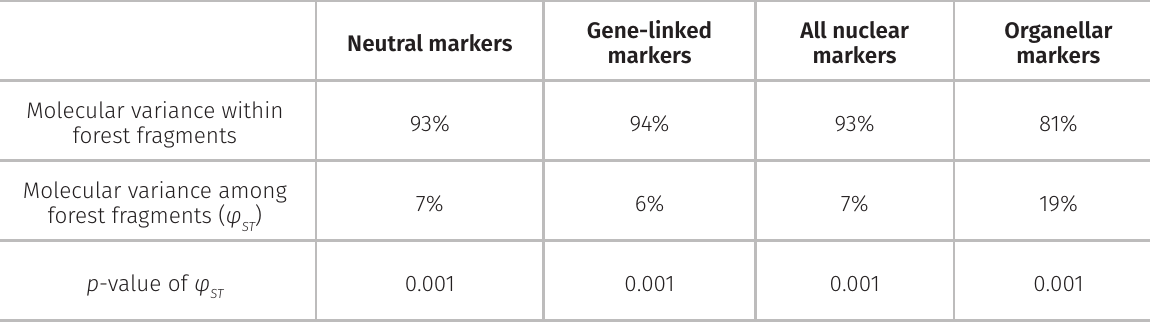
Table II. Analysis of molecular variance (AMOVA) estimated considering four categories of SSR markers